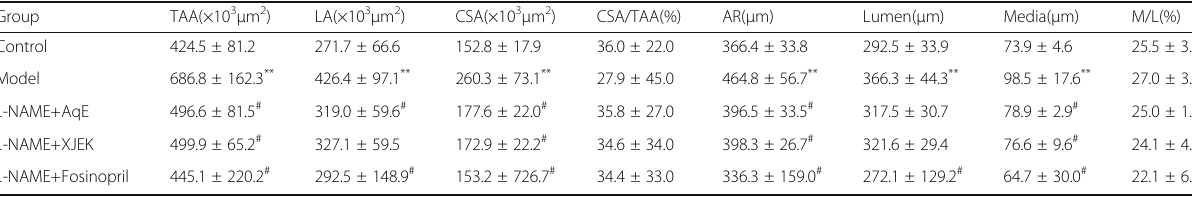
Table 3 Effects of AqE on aorta remodeling in L -NAME induced hypertensive mice (mean ± SD, n = 10)